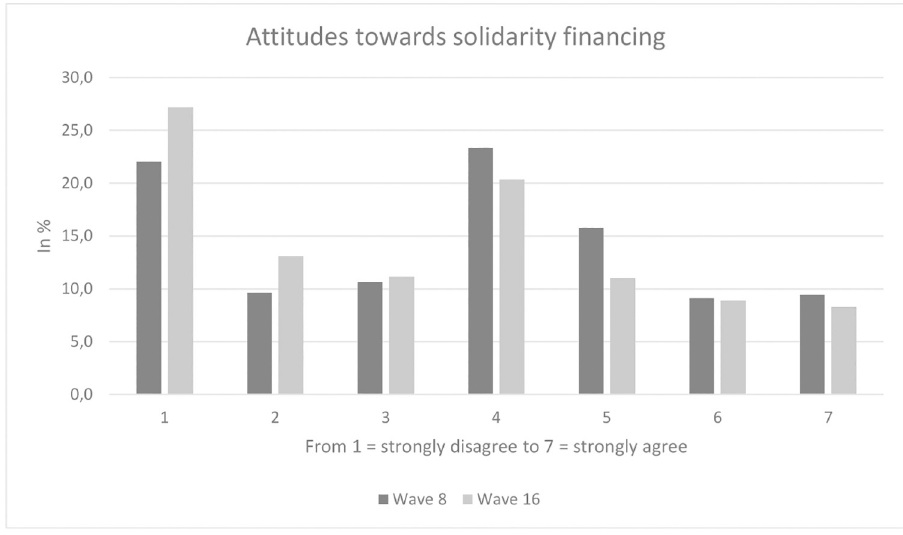
Fig 2. Attitudes towards solidarity